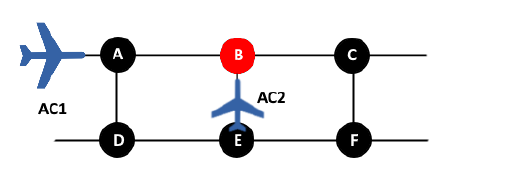
Figure 6. Anticipated crossing conflict example. Node B is the conflict node.